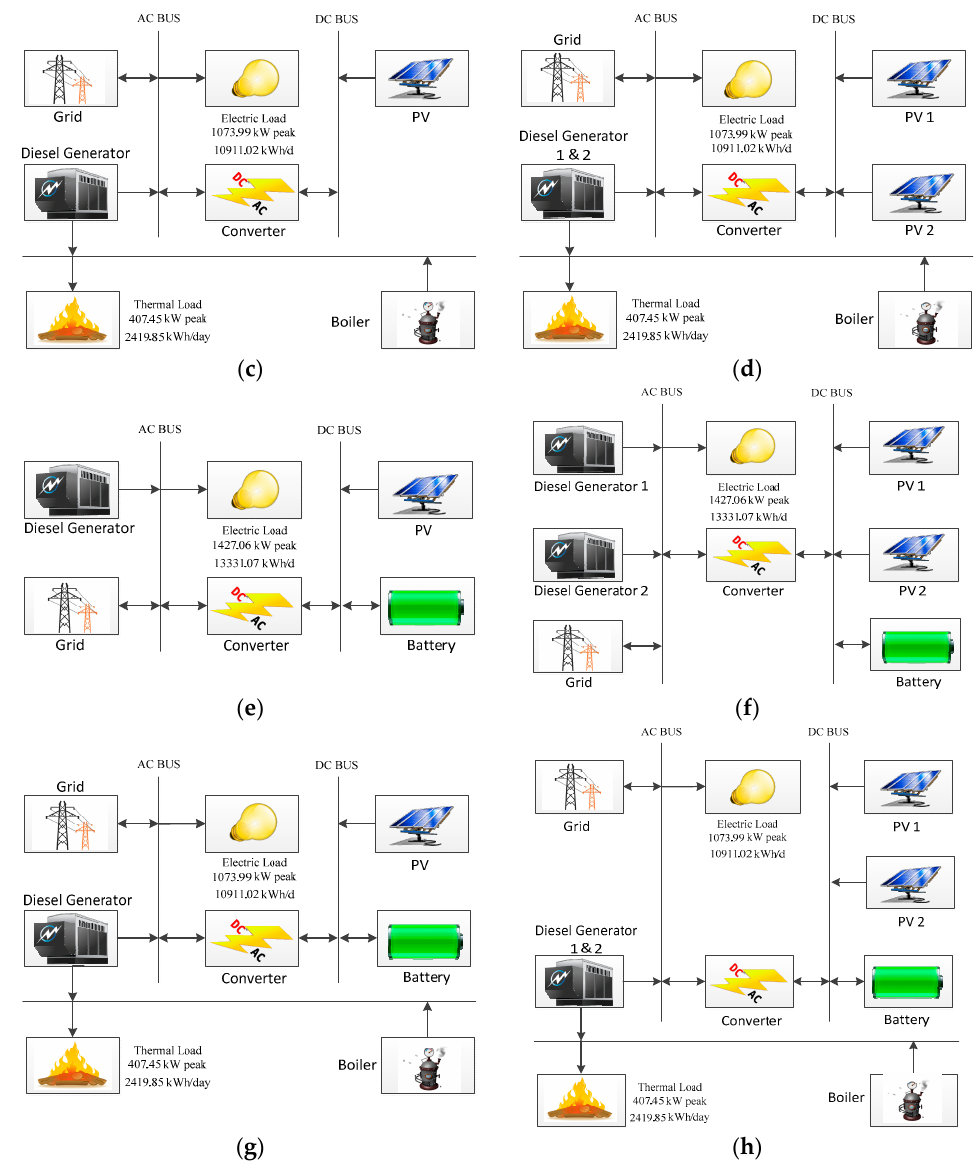
Figure 8. ( a ) Grid-connected single generator (1Gen) and single PV (1PV) without WHR system ( b ) Grid-connected double generator (2Gen) and double PV (2PV) without WHR system ( c ) Grid-connected single generator (1Gen) and single PV (1PV) with WHR system ( d ) Grid-connected double generator (2Gen) and double PV (2PV) with WHR system ( e ) Grid-connected single generator (1Gen), single PV (1PV) and battery without WHR system ( f ) Grid-connected double generator (2Gen), double PV (2PV) and battery without WHR system ( g ) Grid-connected single generator (1Gen), single PV (1PV) and battery with WHR system ( h ) Grid-connected double generator (2Gen), double PV (2PV) and battery with WHR system.